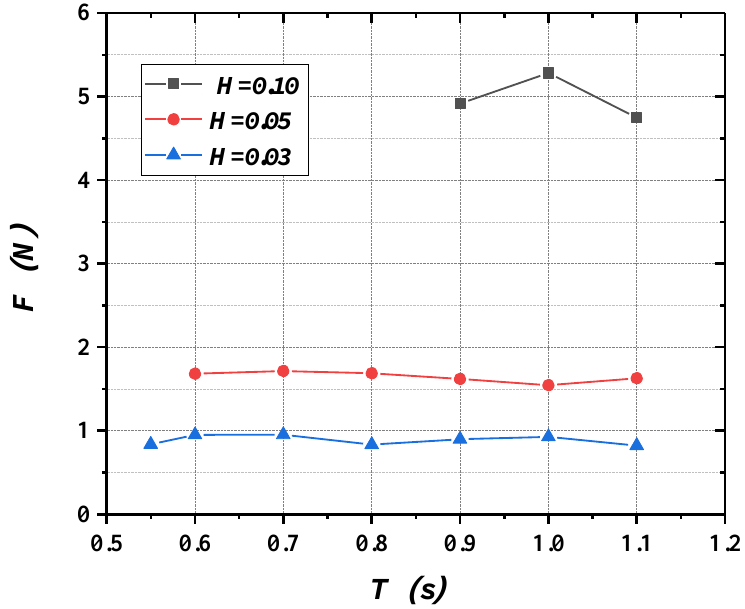
Figure 34. Variations of 5# mooring force.